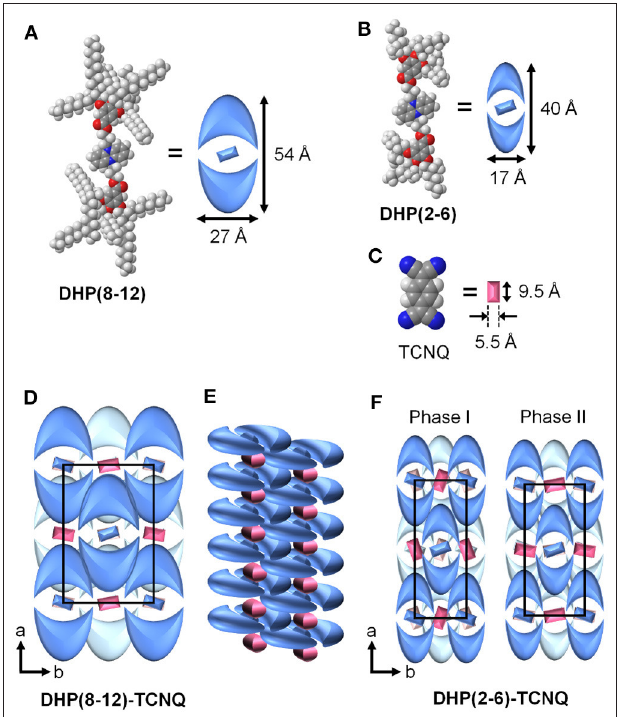
FIGURE 5 | Schematic representation of (A) DHP(8-12) , (B) DHP(2-6) , (C) TCNQ. (D) Estimated packing model for DHP(8-12)-TCNQ viewed from the column axis ( c -axis). Molecules on the back layer are shown in a lighter color. (E) Schematic packing model for neighbor columns of DHP(8-12)-TCNQ , showing that the alkyl chains are penetrated each other. (F) Estimated packing model for DHP(2-6)-TCNQ viewed from the column axis ( c -axis).